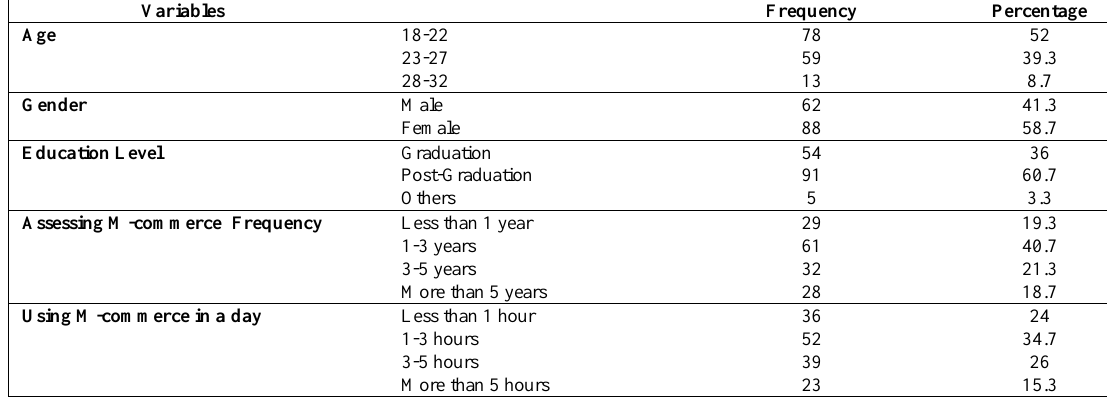
Table 1. Demographic profile of